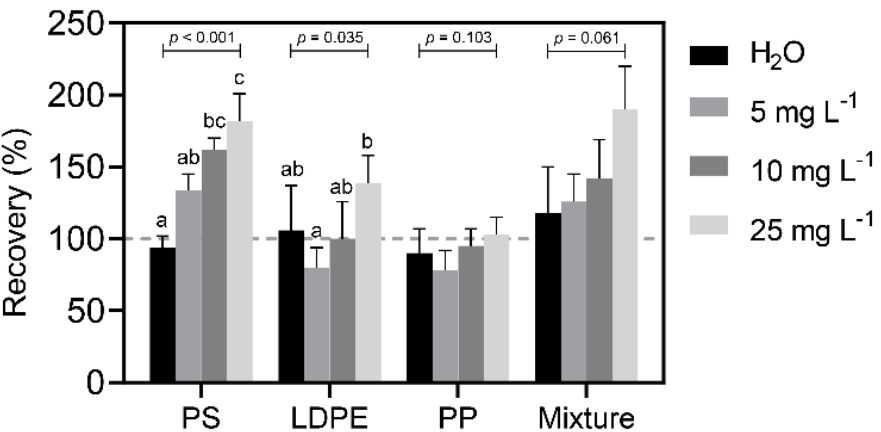
Figure 6. Recoveries (%) of MPs counted in the presence of different concentrations of organic carbon. Three types of polymers (PS, LDPE and PP) and a mixture (1:1:1) of all three plastic types were assessed, with the final concentrations of 900 particles mL − 1 . Each bar and error bar represent mean % recoveries ( n = 7) and relative standard deviations, respectively. The dashed line represented 100% recovery. The p values are the results of one-way ANOVA to compare the % recoveries between organic carbon concentrations for each polymer or mixture. Bars with different letters indicate significant differences of % recoveries among organic carbon concentrations at the level of p < 0.05.